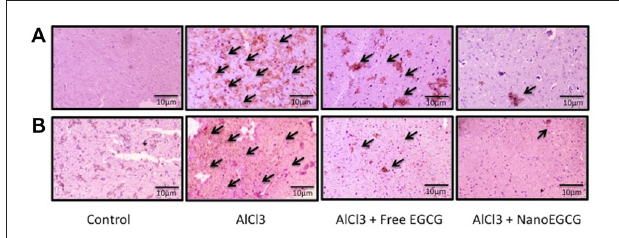
FIGURE 4 | Representative immunohistochemical images in the (A) cortex and (B) hippocampus regions of the rat brain ( n = 3). The arrows are indicative of A β 1–42 levels.